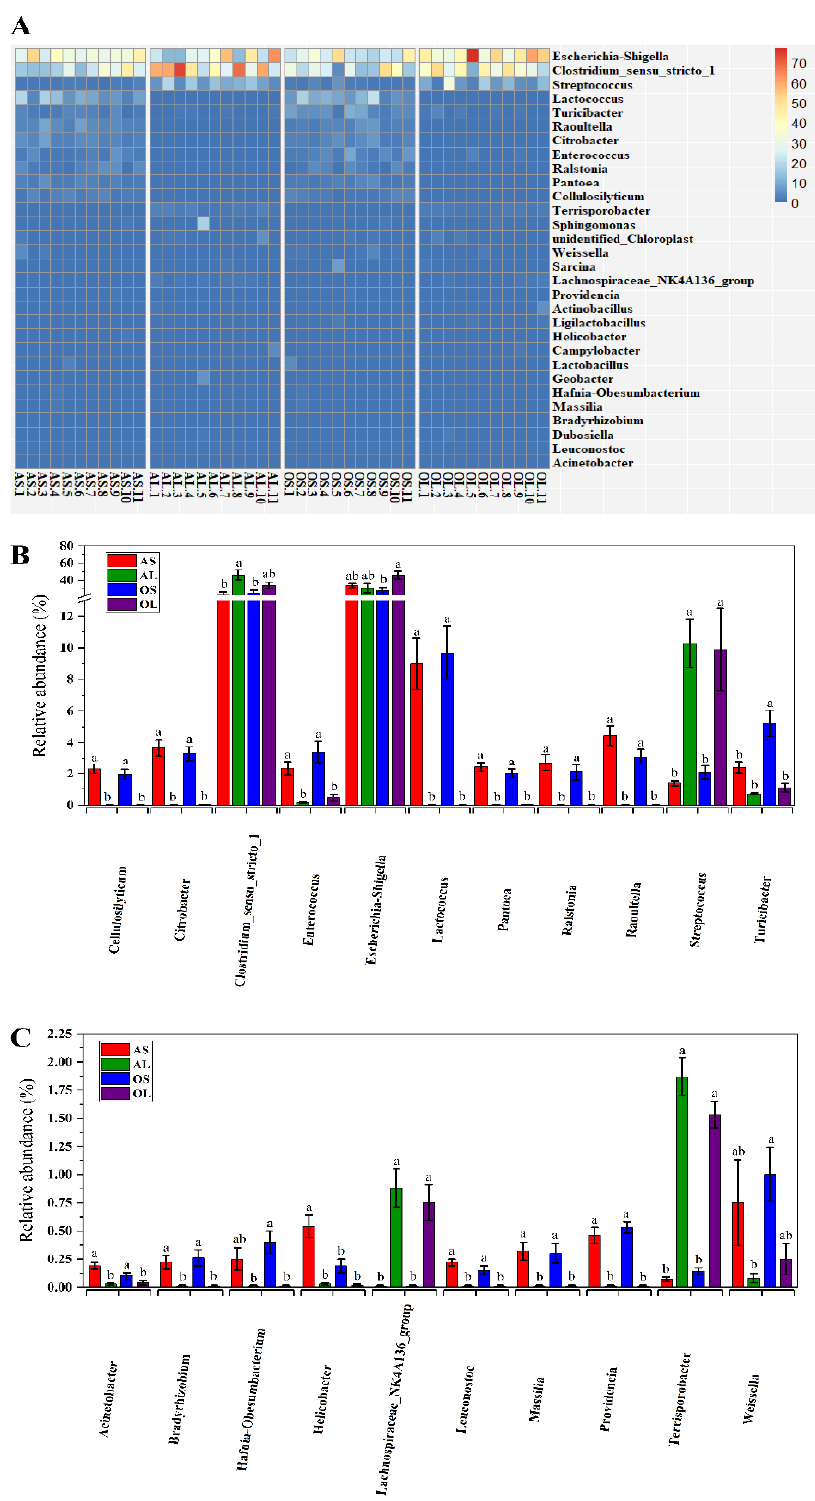
bamboo leaves. In panel B and C, values are presented as mean ± standard error; bars with different letters mean significant difference ( p < 0.05).